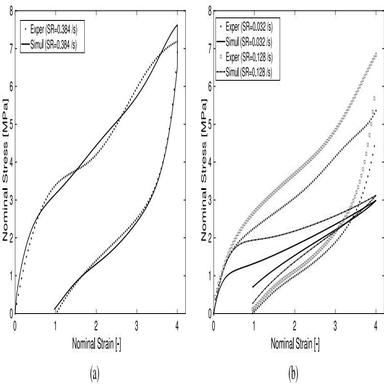
Viscous parameters identification with a loading–unloading cyclic data for 400% strain at a strain rate of 0.384 /s with linear relaxation times: (a) Model fitting with one Yeoh and four Neo–Hooke Maxwell elements with ten viscous parameters (total thirteen parameters; three elastic and ten viscous), (b) model validation with one Yeoh and four Neo–Hooke Maxwell elements (thirteen parameters in total).